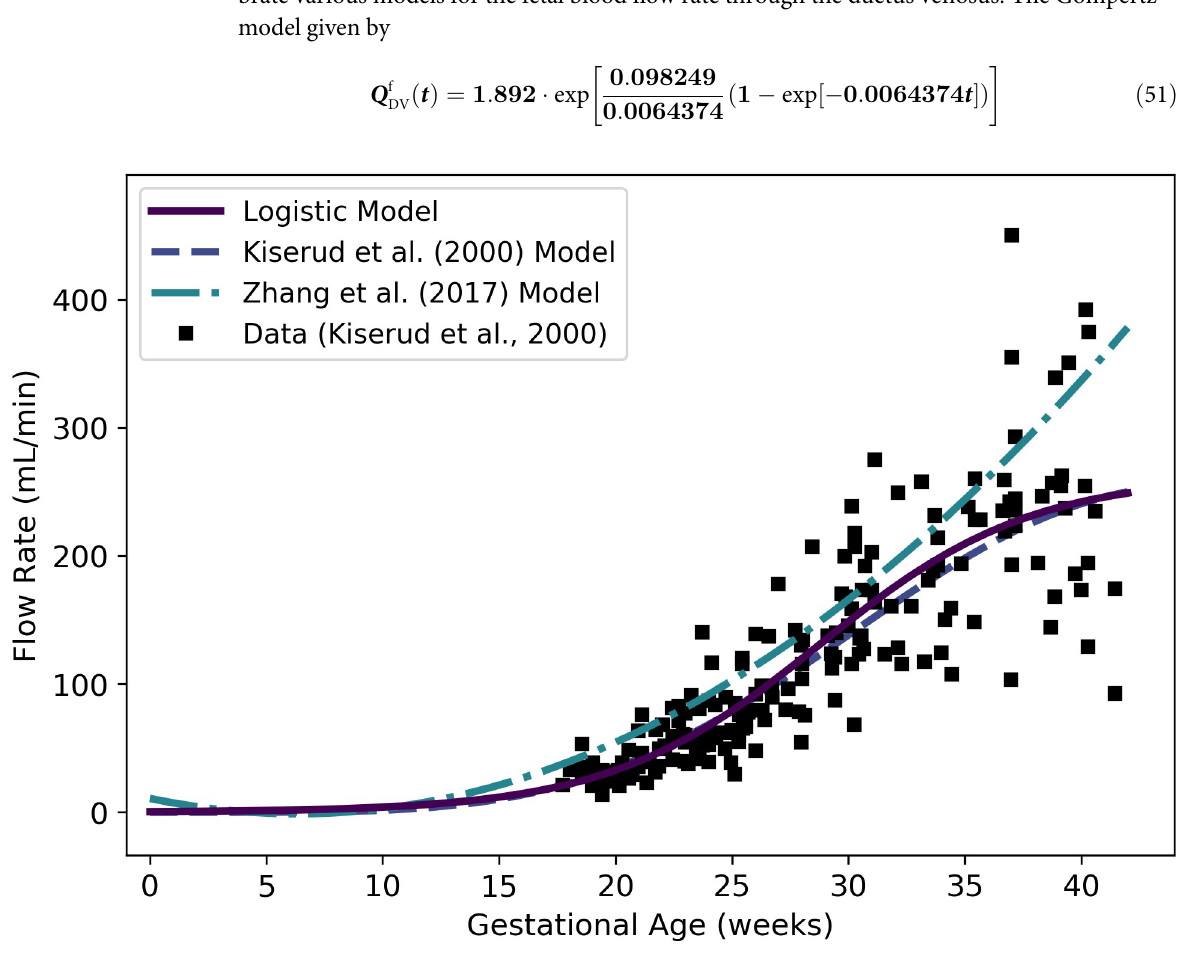
Fig 25. Fetal blood flow through the placenta vs. gestational age. The logistic model (solid line) given by Eq 50 was selected as the most parsimonious model in our analysis. The model of Kiserud et al. [40] was calibrated using the same data set [40] used by us, whereas the model of Zhang et al. [32] was calibrated using a different compiled data